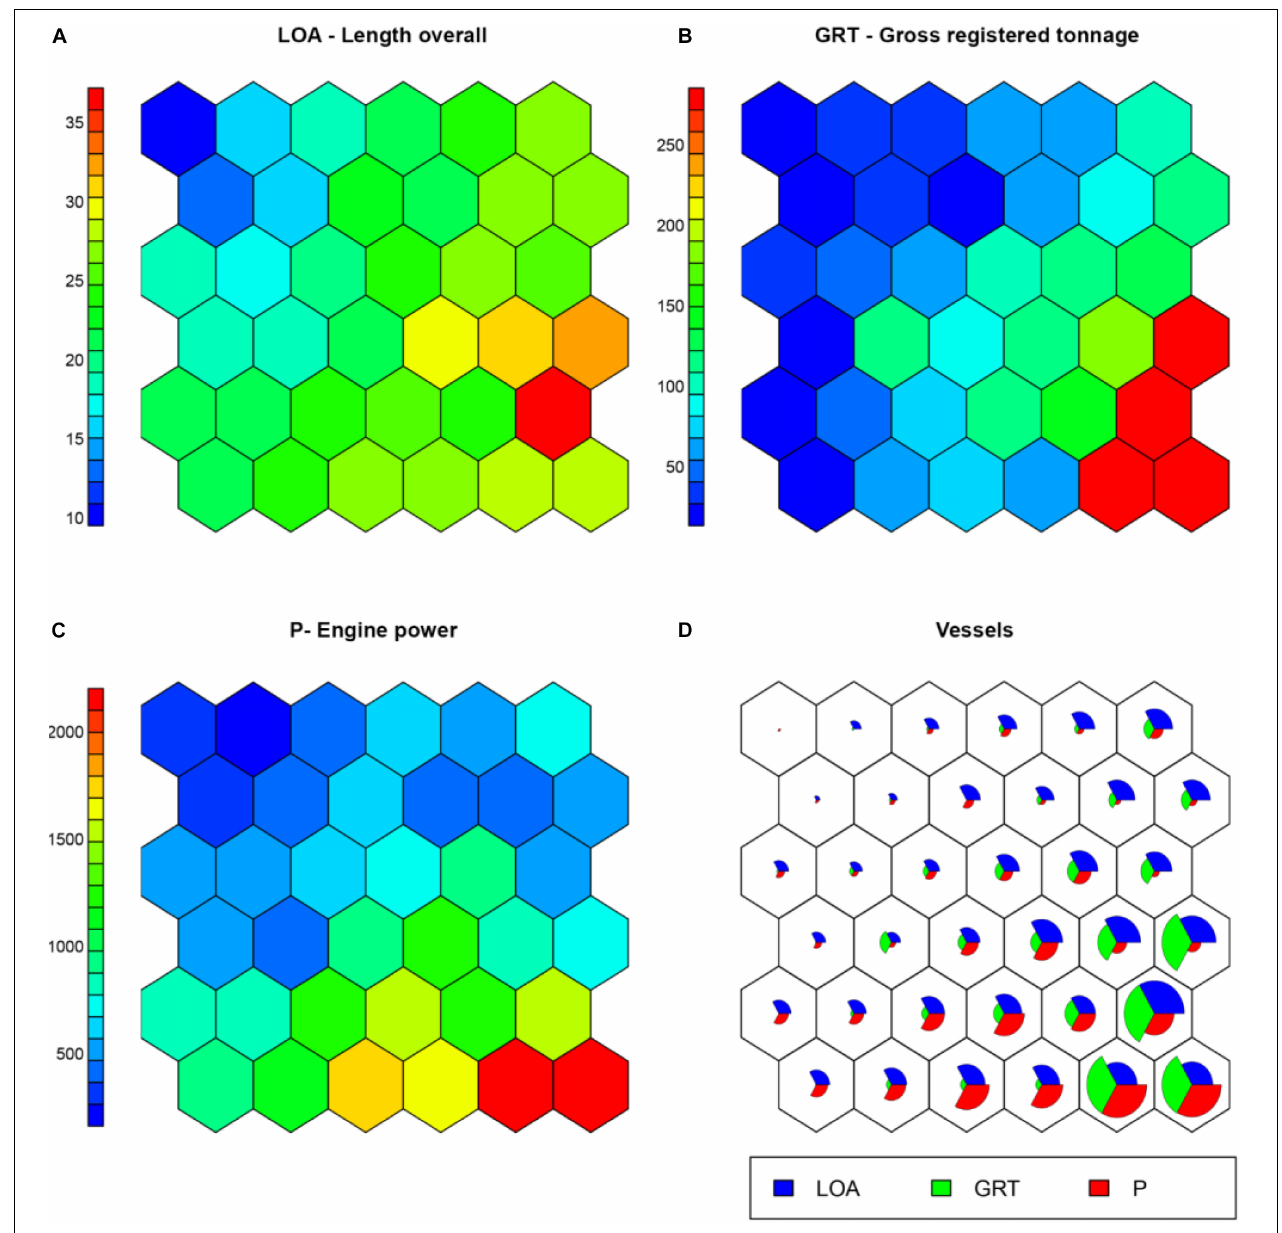
FIGURE 3 | Results of the first trained SOM. From (A–C) the patterns of the considered unscaled vessel metrics are represented in a color scale; (D) shows the “codes plot,” representing the magnitude of each variable per output unit.